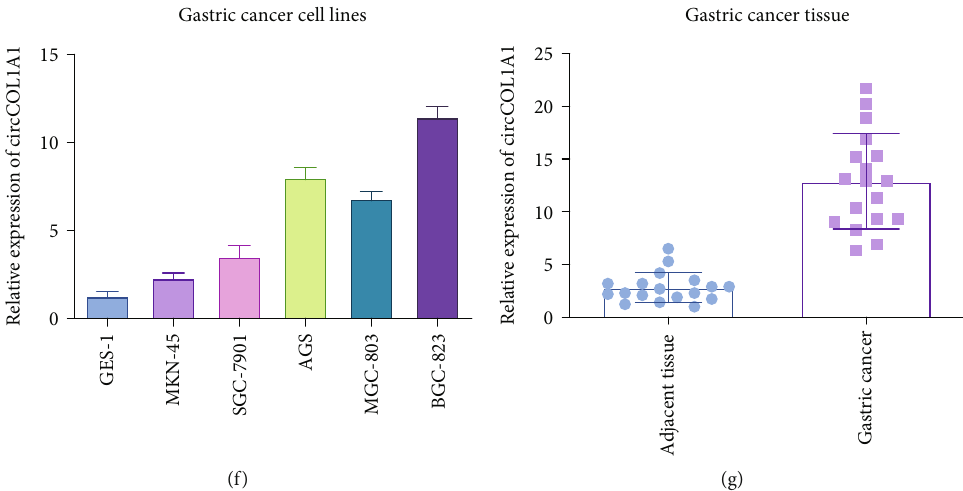
Figure 1: Characterization of circCOL1A1 in gastric cancer. (a) PCR was performed in BGC-823 and AGS. circCOL1A1 was ampli fi ed by specially designed divergent primers from cDNA but not from genomic DNA (gDNA). Linear COL1A1 RNA was ampli fi ed by convergent primers both in cDNA and gDNA. GAPDH was an endogenous control. (b, c) RNase R was used to pretreat the RNA, and qRT-PCR was used to determine the resistance. circCOL1A1 was resistance to RNase R in BGC-823 and AGS cell lines. (d, e) BGC-823 and AGS were treated with 5mg/ml actinomycin D for 0, 4, 8, 12, and 16h. RNAs extracted and determined by qRT-PCR analyses. (f) Expression of circCOL1A1 in di ff erent gastric cancer cells and normal cells. (g) qRT-PCR was applied to determine the expression of circCOL1A1 in gastric cancer